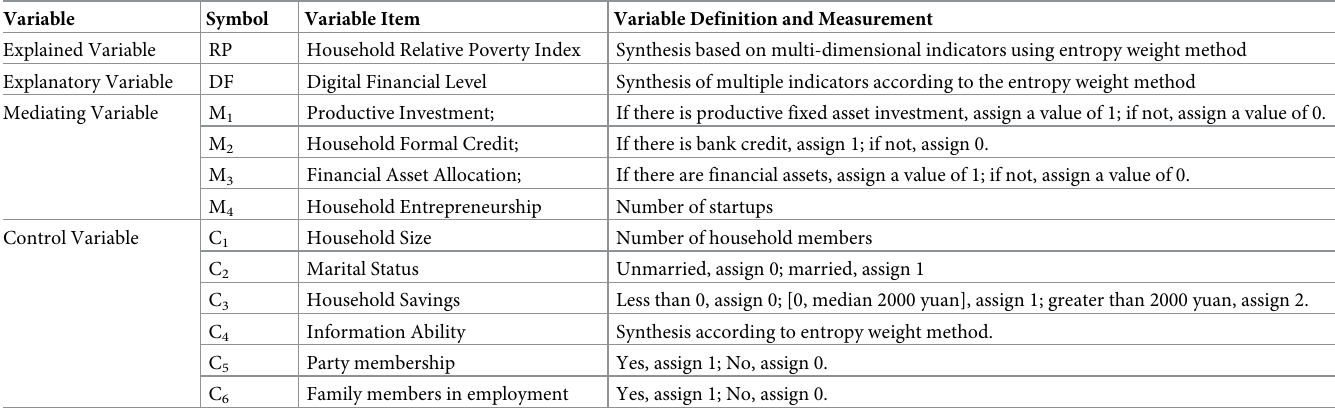
Table 1. Variable definitions and measurement.